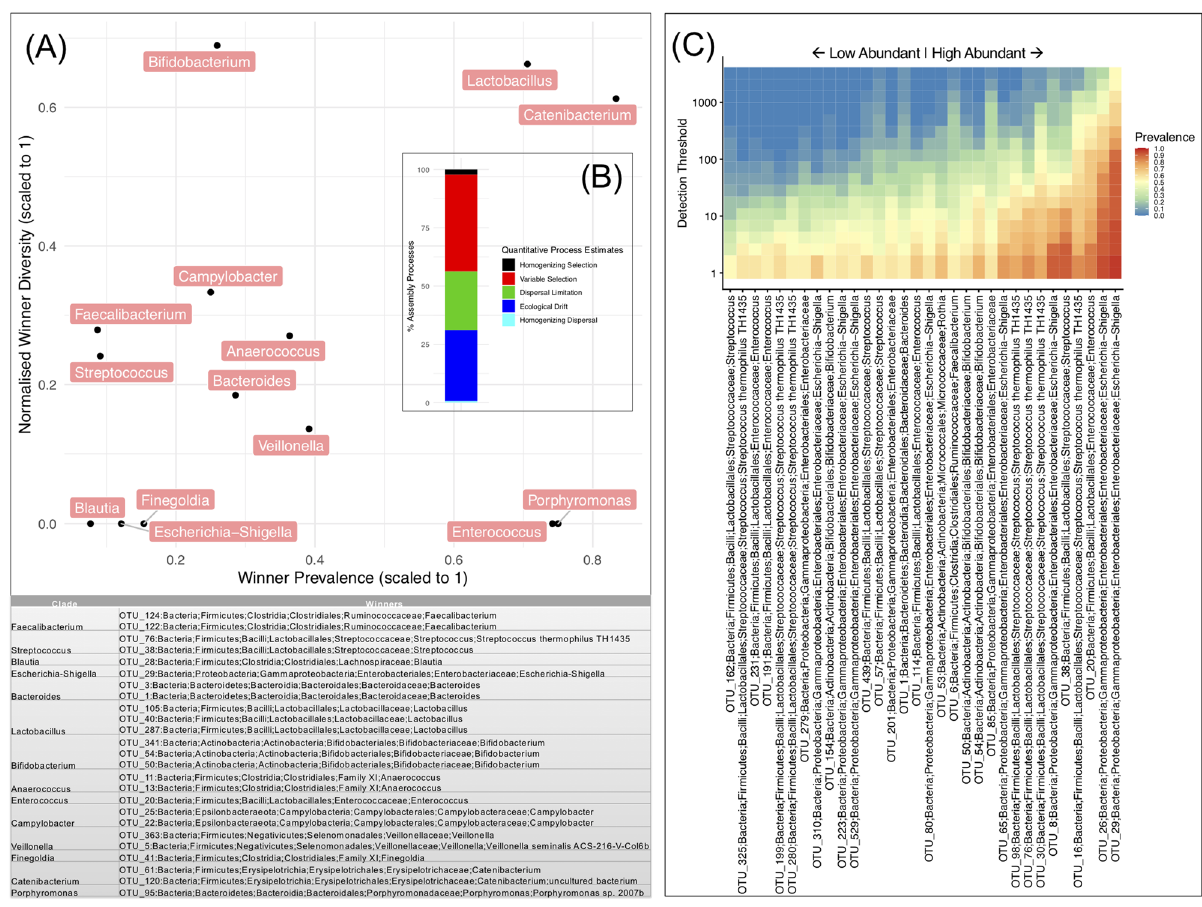
Figure 10. Community structure of samples with “stunted” status. ( A ) Competitive lottery model for conceptualising community assembly of these samples with genera displaying lottery-like behaviour plotted by prevalence and diversity of the ‘winning’ OTUs; these ‘winning’ OTUs (> 90% abundance for that clade) from each clade are given in the bottom table. The inset ( B ) gives the assembly processes using QPE estimates. ( C ) Core microbiome of samples with “stunted” status where we have used a minimum prevalence of 50% of OTUs in these samples as the lower